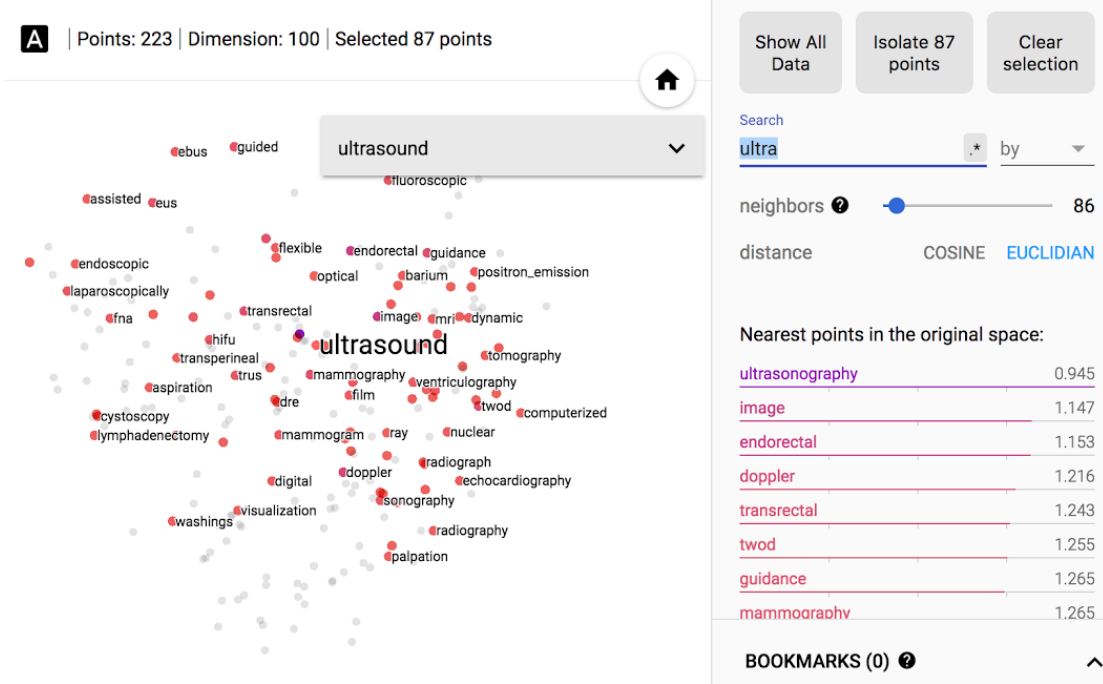
Figure 6. Search for “Ultrasound” on the Tensorboard Embedding Projector.